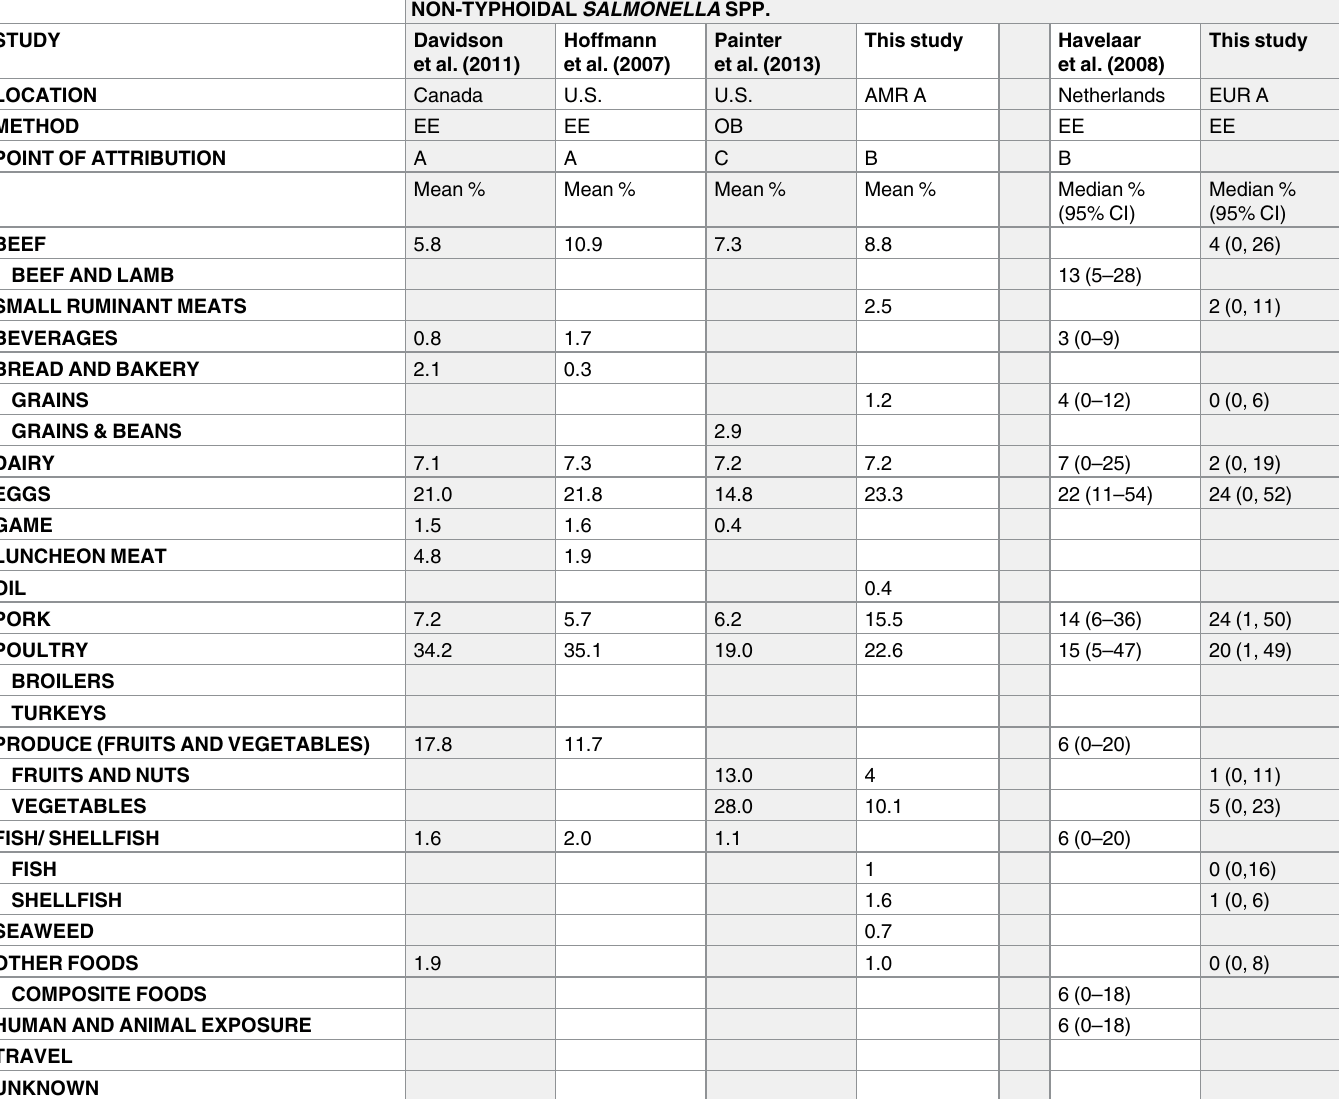
Table 5. Non-typhoidal Salmonella spp. Percent of foodborneillnessesattributed to specifiedfood exposures from prior national studies and this study. NON-TYPHOIDAL SALMONELLA